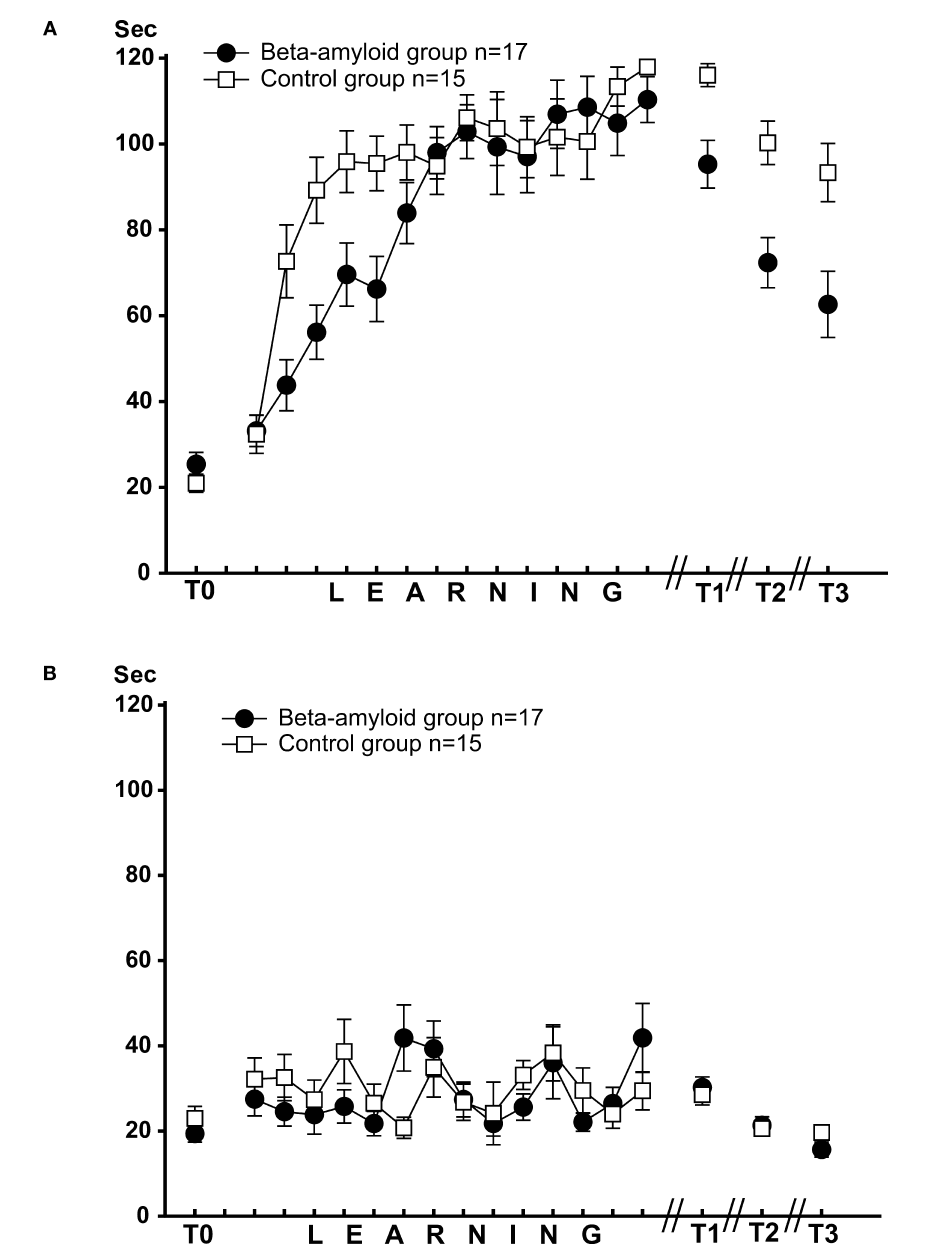
Figure 3 | Dynamics of food-aversion learning on the ball estimated by average latency of food grasping by the snail. (A) Dynamics of carrot aversion learning in control snails ( n = 15) and β AP-injected snails ( n = 17). X -axis – days of experiment (see Figure 2 for detailed protocol), Y -axis – latency period (seconds) of carrot-grasping. (B) Changes in latency of food grasping in response to cabbage presentations in control snails ( n = 15) and β AP-injected snails ( n = 17). X -axis – days, Y -axis – latency period (seconds) of cabbage